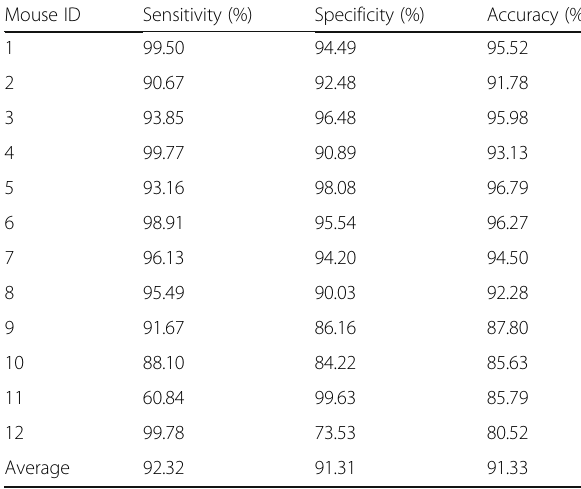
Table 1 The performance of cancer detection for 12